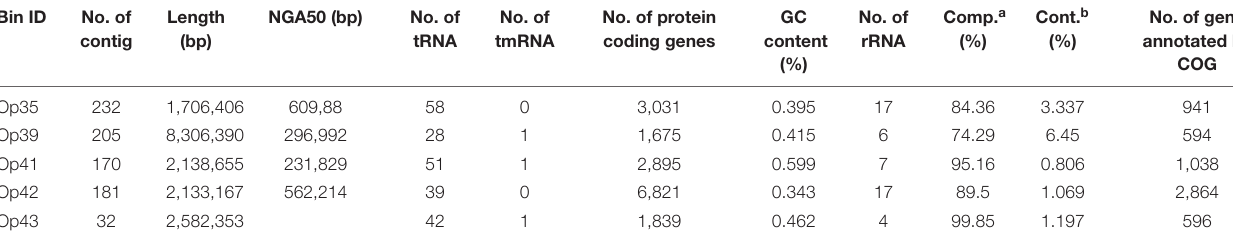
abundance obtained from metagenomic analysis ( Figure 7B